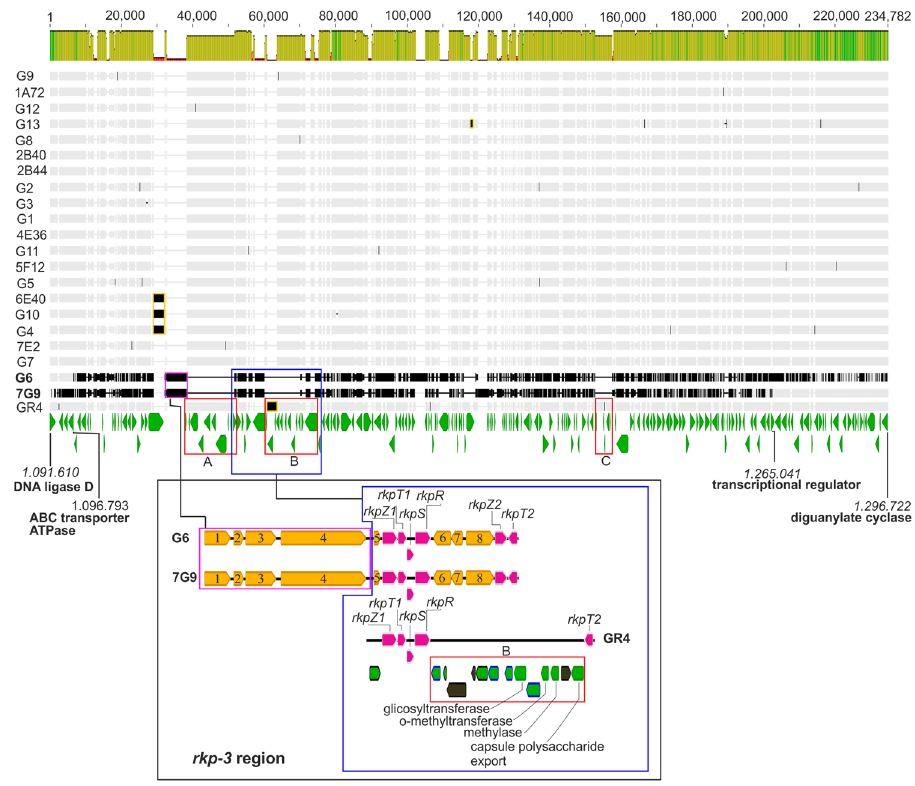
Figure 2. Comparison of the genome region encompassing the GID of pSymB in the GR4-type population. Alignment (Supplementary Data 2) of GR4-type isolates for the region of the genome encompassing the GID on pSymB. Mean pairwise identity is shown above the alignment (bright green: 100% identity), khaki green (between 30% and 100% identity). Transposase sequences in the alignment are framed in yellow and discordances with respect to the consensus are shown in black. The genes at the left and right boundaries are indicated (DNA ligase D, WP_015243213.1; ABC transporter ATPase, WP_015243216.1; transcriptional regulator, WP_015243340.1; and diguanylate cyclase, WP_015243358.1), together with their coordinate positions in the reference strain GR4 pSymB replicon. The genes identified in the GR4 population are shown below the alignment in green. The three major regions (A, B and C) containing genes mostly encoding hypothetical proteins absent from the isolates are indicated. An enlargement of the rkp-3 region and its genetic organization is also shown. Genes with only distant homologs in databases are shown in orange and numbered: methyltransferases (1 and 3); a hypothetical protein (2); glycosyltransferases (4, 7 and 8); a nucleotidyl transferase (5) and a sugar phosphotransferase (6). The conserved rkp genes are shown in pink. In enlarged region B, the transposases are shown in black, the annotated truncated genes are framed in black, and the genes encoding hypothetical proteins are framed in